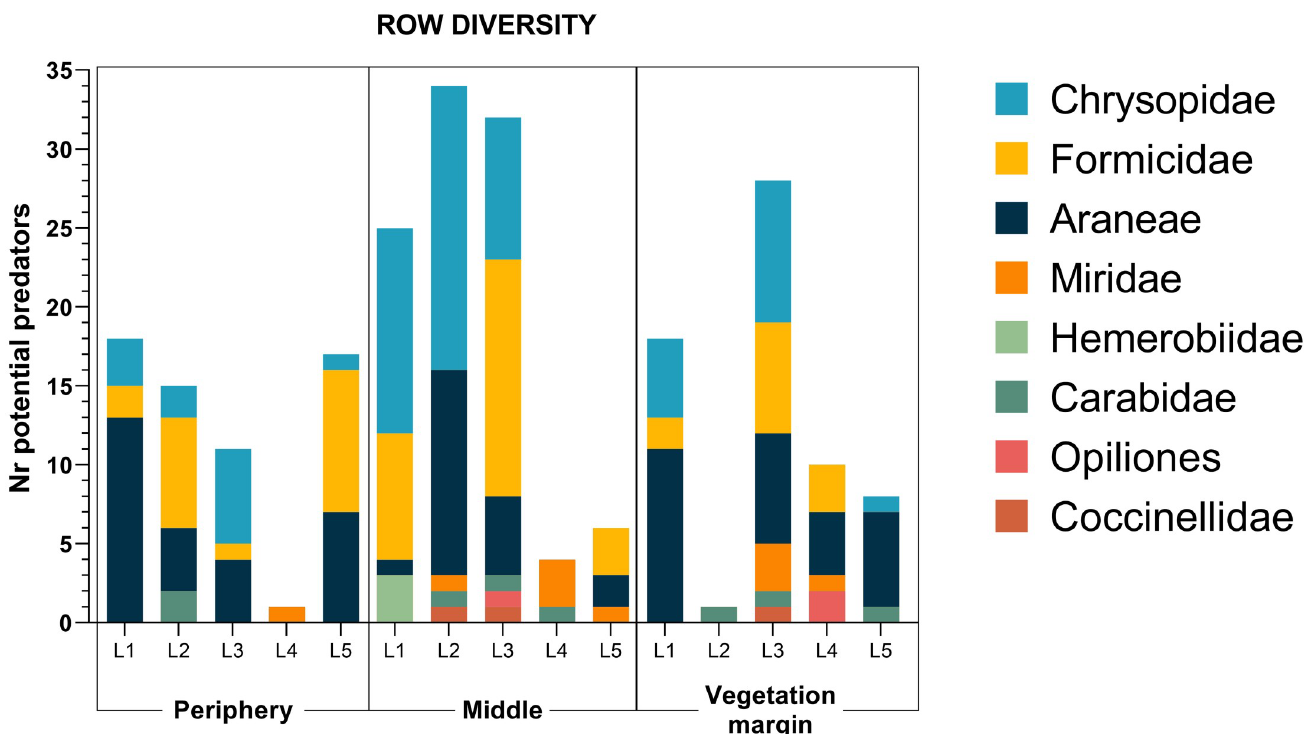
Fig 5. Arthropod row diversity (D-VAC+Pitfall traps). Periphery—row in the periphery of the orchard; Middle—row in the middle of the orchard; Vegetation margin—row closer to wild vegetation, a water source and/or shade. Values are presented as the total number of individuals collected in each row of each location. https://doi.org/10.1371/journal.pone.0249673.g005 Carabidae, Opiliones and Araneae, with no detection of D . suzukii DNA in Coccinellidae indi- viduals (Fig 6a). Regarding the Araneae functional groups, D . suzukii DNA was detected only on 2 of the 7 functional groups, namely orb web weavers (family Araneidae and Uloboridae) and space web weavers (family Dictynidae and Theridiidae), all collected with D-Vac (Fig 6b). The most abundant taxonomic groups with positive results were Chrysopidae, Formicidae and